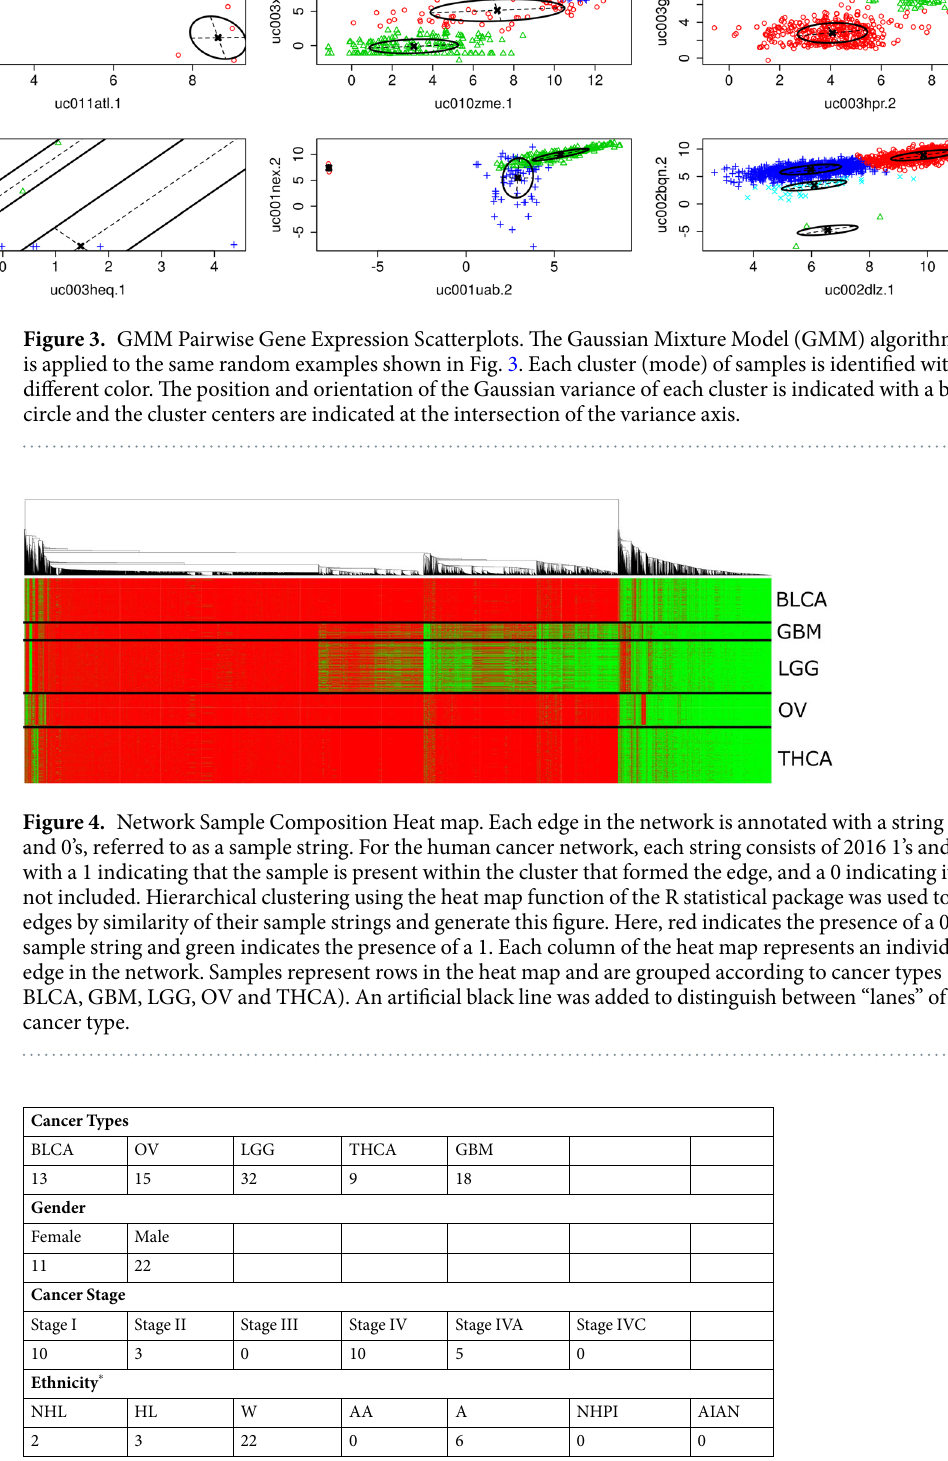
Table 1. GMM Network Modules with Enriched Clinical Annotations. Each value indicates the number of modules in the GMM network enriched for the specified annotation with a p -value < 0.001. BLCA (bladder cancer), OV (ovarian cancer), LGG (lower grade glioma), THCA (thyroid cancer), GBM (glioblastoma), NHL (not Hispanic or Latino), HL (Hispanic or Latino), W (White), AA (African American), A (Asian), NHPI (Native Hawaiian or Pacific Islander), AIAN (American Indian, Alaska Native).